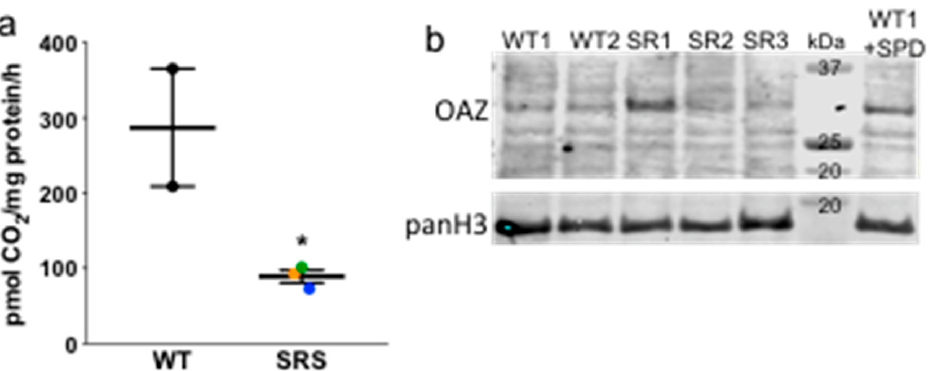
Figure 3. ( a ) ODC activity in donor or SRS lymphoblasts ( n = 2, in triplicate; error bars = SEM), presented as pmol CO 2 produced per hour per mg of total protein. Color designations are orange (SRS1), blue (SRS2), and green (SRS3). ( b ) Representative Western blot of ODC antizyme 1 (OAZ1) with pan histone H3 as loading control. The WT1 cell line treated with SPD for 24 h was used as a positive control for OAZ1. * p < 0.05.